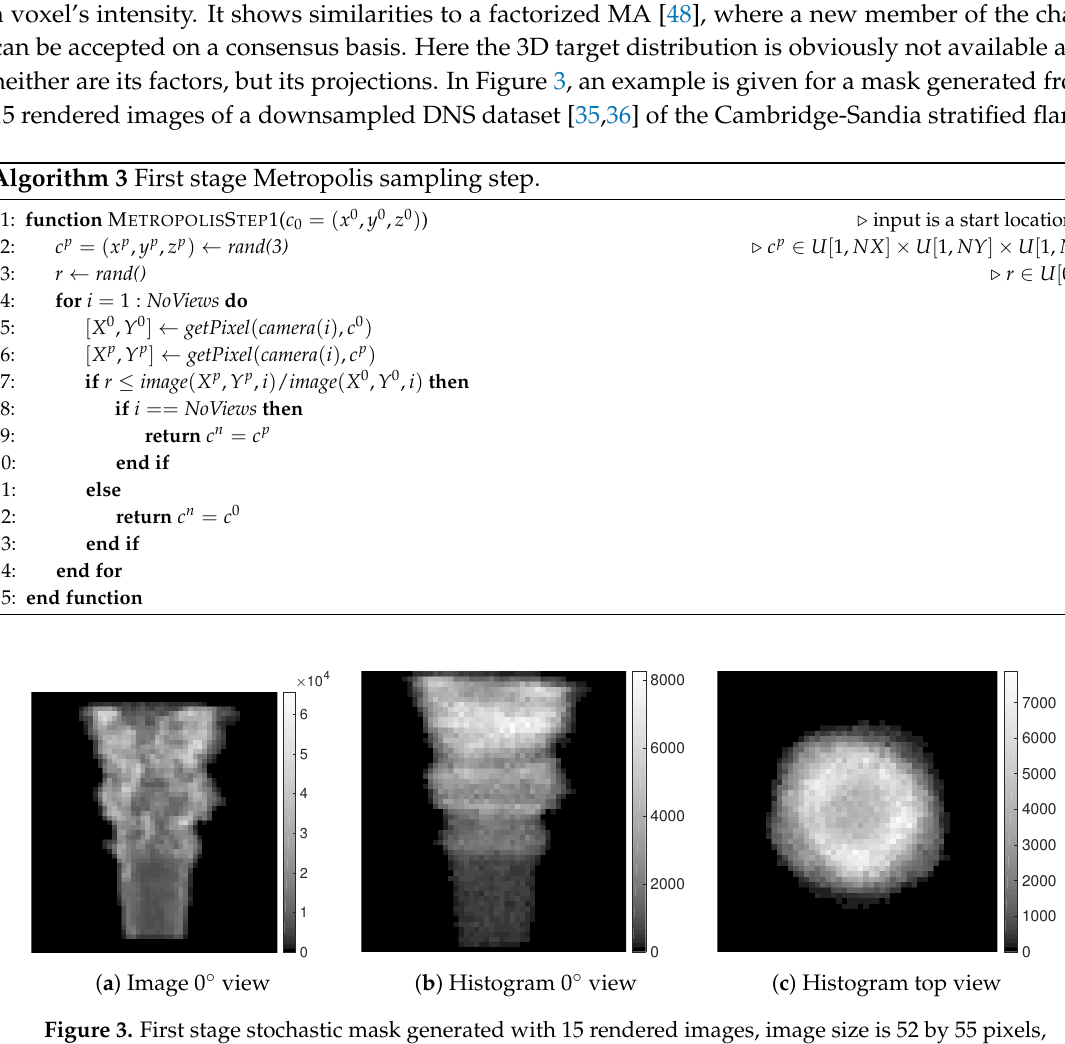
Figure 3. First stage stochastic mask generated with 15 rendered images, image size is 52 by 55 pixels, three million samples were